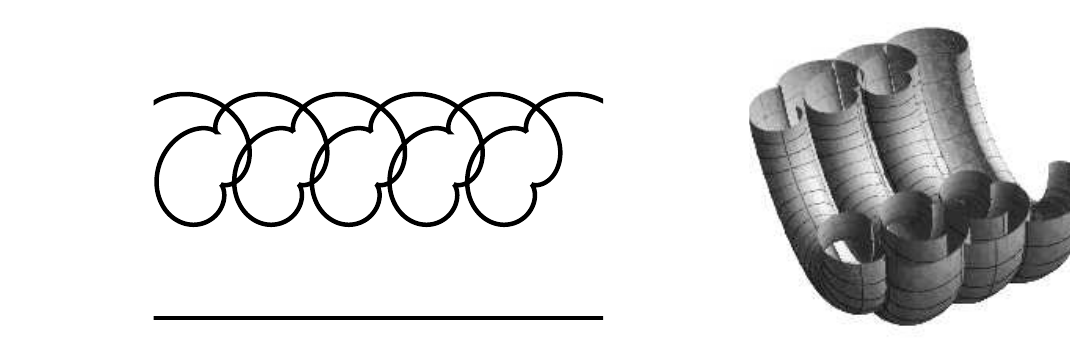
Figure 3 - Generating curve and the surface of revolution of Example 3.3.